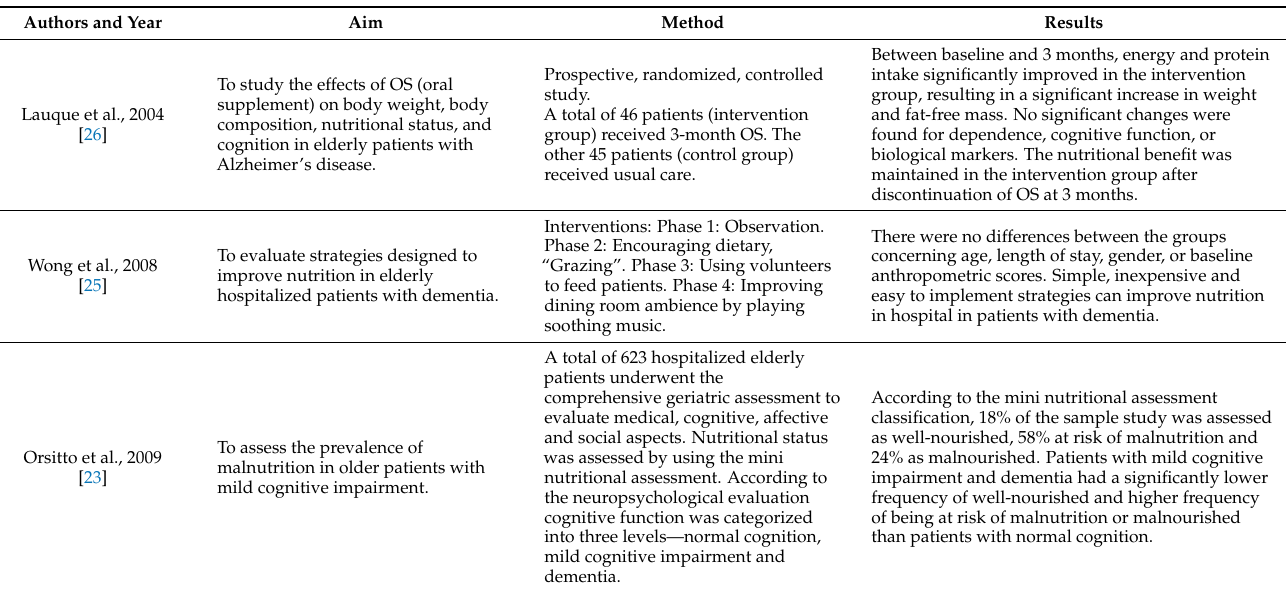
Table 1. Summary of